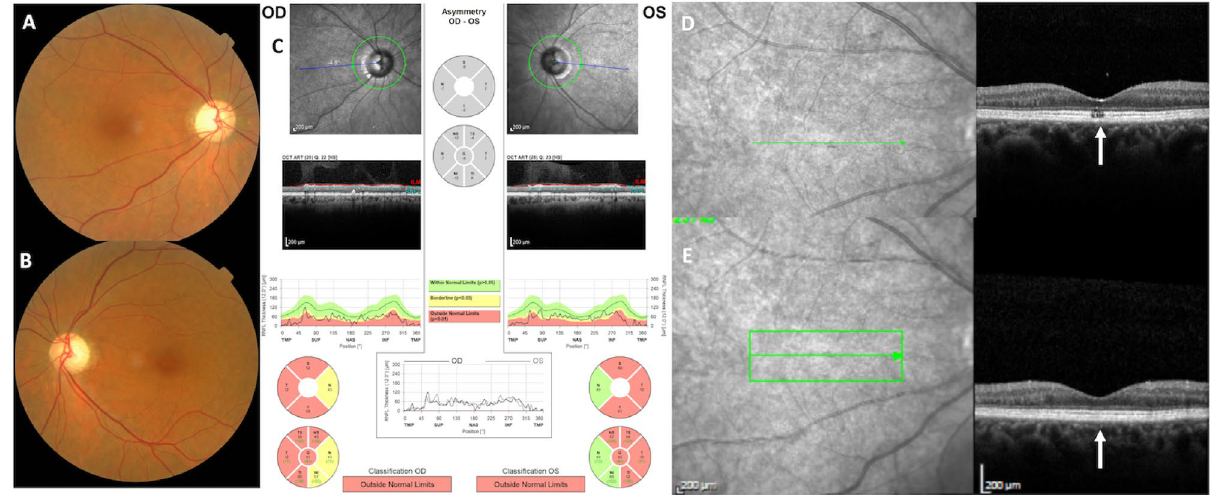
Figure 2. SSBP1 -related DOA mimics OPA1 -related DOA. Imaging analysis showing a temporal pallor ( A , B ) and significant bilateral thinning of the temporal retinal nerve fiber layer in both eyes ( C ). ( D , E ) Foveal SD-OCT scans in the right eye. In the absence of the specific foveopathy visible only by one SD-OCT scan ( D ), the optic atrophy is indistinguishable from the OPA1 -related form. Photographs were taken by IM.